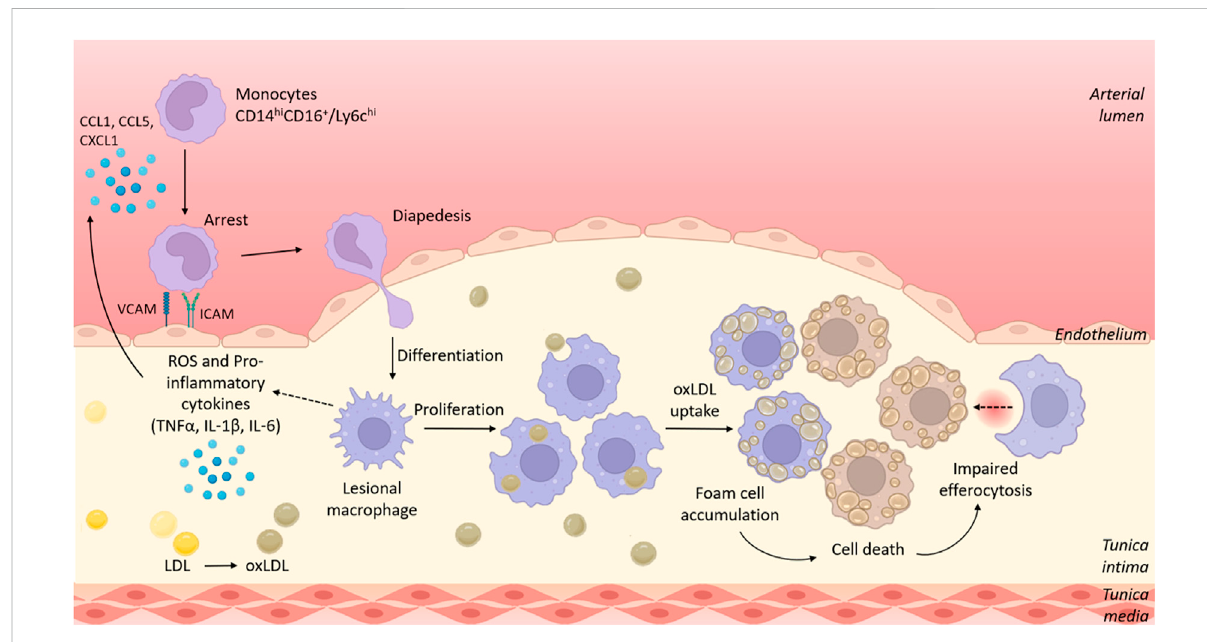
FIGURE 1 The role of myeloid cells in the development of atherosclerotic lesions. Circulating murine Ly6c hi /human CD14 hi CD16+ monocytes are recruited to sites of atherosclerotic plaques/fatty streaks via signalling of chemokines such as CCL2, CCL5 and CXCL1. Recruited monocytes adhere to the activated endothelium that overexpresses adhesion molecules including VCAM-1 and ICAM-1. Monocytes transmigrate through the endothelium where they differentiate into macrophages. Initially monocyte recruitment, and later local proliferation of lesional macrophages contributetogrowingplaquesize.Withintheplaque,macrophagesadoptapro-in fl ammatoryphenotype,resultinginproductionofreactiveoxygen species(ROS)andpro-in fl ammatorycytokinessuchasTNF α ,IL-1 β andIL-6.Lesionalmacrophagesphagocytoseoxidisedlipoproteins via scavenger receptorssuchasCD36andbecomelipid-ladenfoamcells.Dyingfoamcellsaccumulatewithintheplaquetoformanecroticcoreinpartbecauseof impaired cell clearance via efferocytosis. Figure generated using